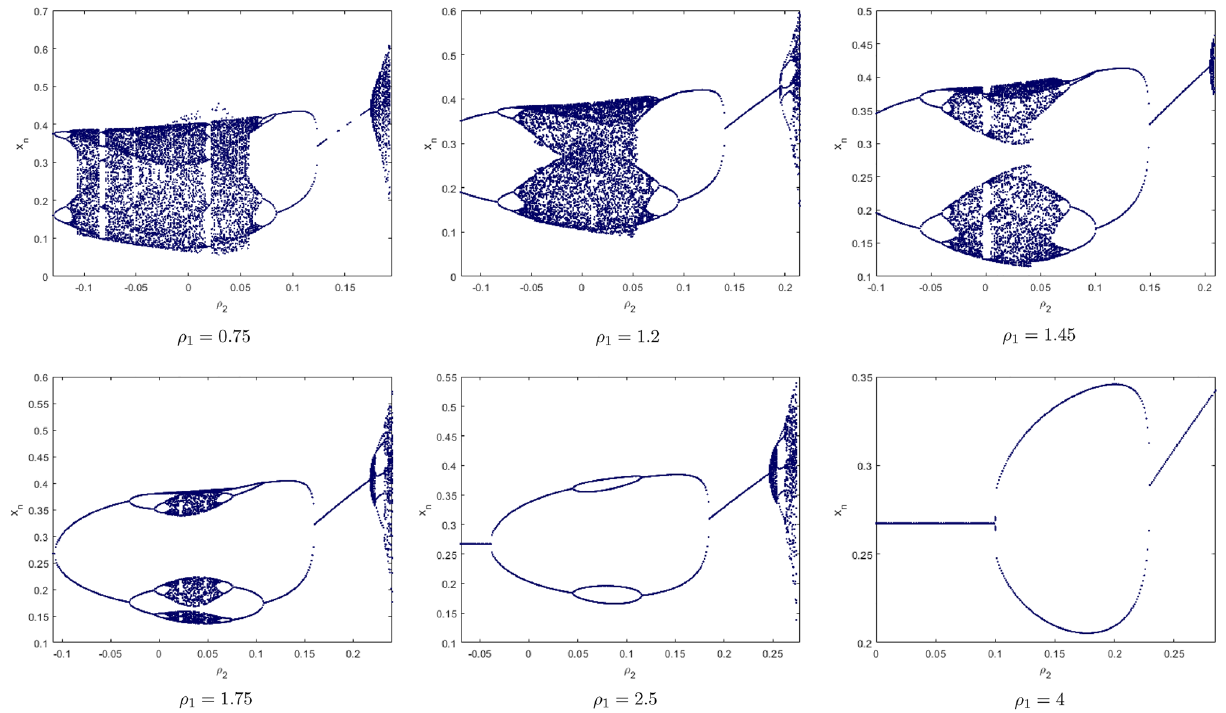
Figure 19. The Phase Chaos of the controlled system